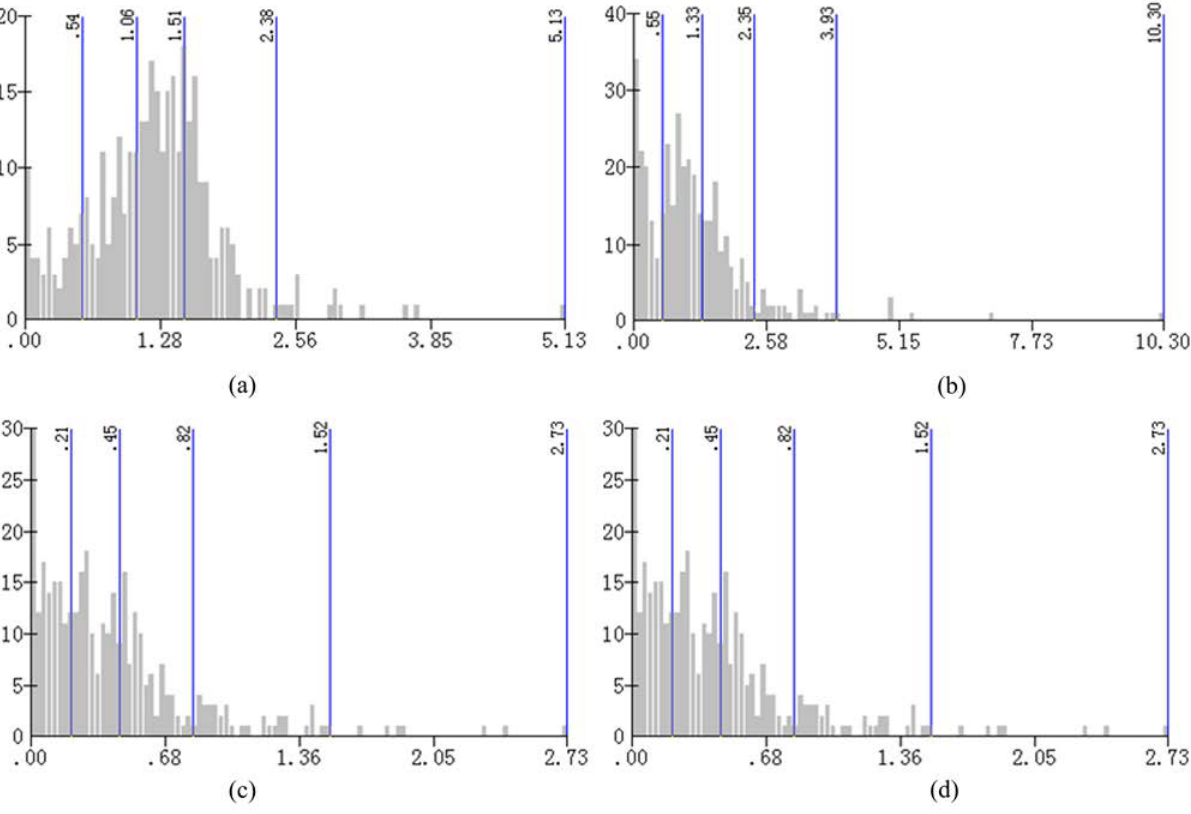
Figure 2. The classification of floor area ratio of the four types of construction